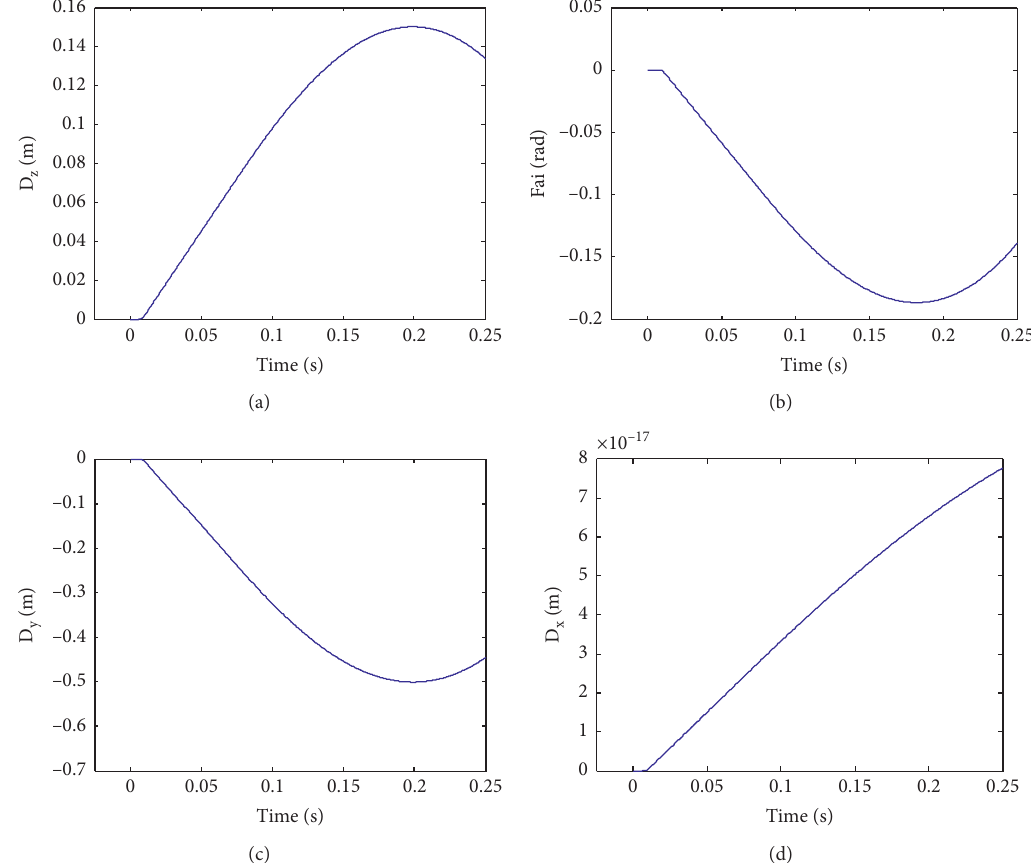
Figure 3: Rigid motion response of platform. (a) Heave. (b) Roll. (c) Sway. (d)